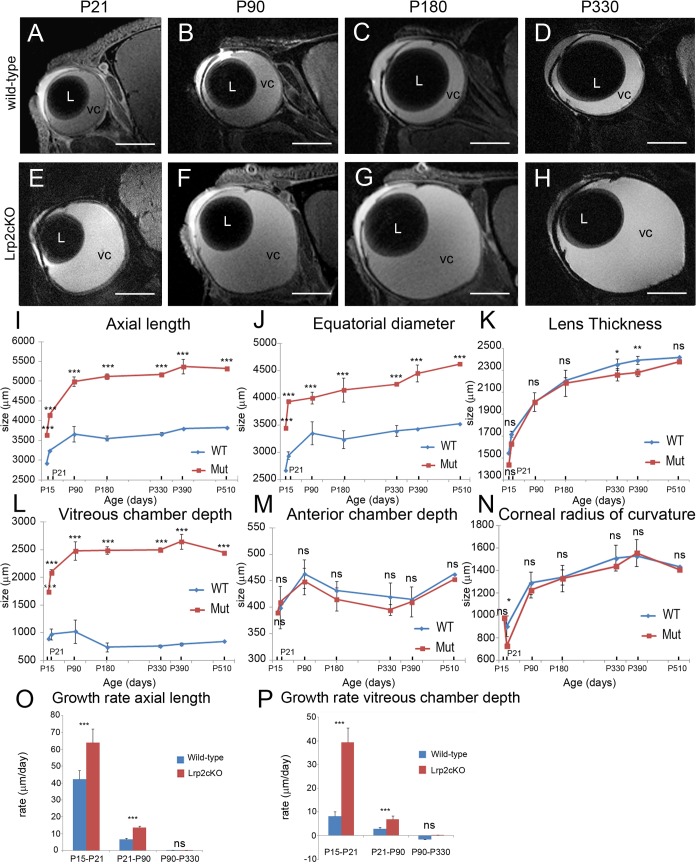
MRI analysis of post-natal eye growth in control and Lrp2
FoxG1.cre-KO mutants over the first year of life.High resolution sagittal slices through the optical axis of the right eye of each mouse were acquired (A-H). A variety of optical parameters were extracted from the MRI images collected from groups of control and mutant mice at the ages indicated (I-N). Growth rate of axial length and vitreous chamber depth (O, P). A two-way ANOVA post hoc Tukey test was used, P<0.05, **P<0.01, ***P<0.001, ns: not statistically significant, values are mean ± SEM of 4 animals per age and genotype. Scale bars: 1500 μm in A-H.